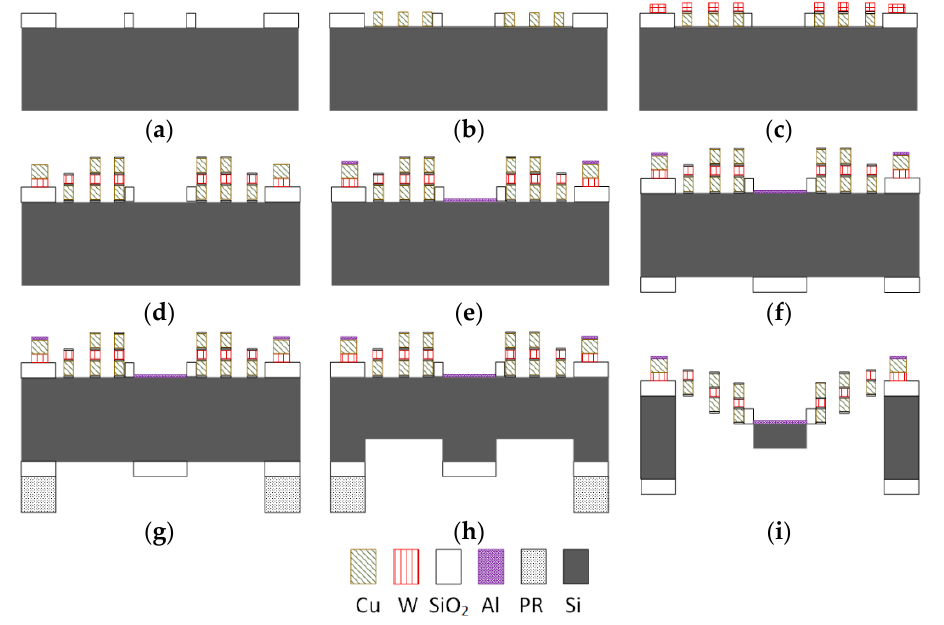
Figure 6. Fabrication process of the Cu/W-based LSF MEMS mirror. ( a ) SiO 2 deposition and wet etch; ( b ) Cu-1 sputtering and lift-off; ( c ) W sputtering and lift-off; ( d ) Cu-2 sputtering and lift-off; ( e ) Al sputtering and lift-off; ( f ) Backside SiO 2 deposition and patterning; ( g ) Backside PR patterning; ( h ) Backside DRIE to certain depth; ( i ) Backside DRIE to remove all Si under.